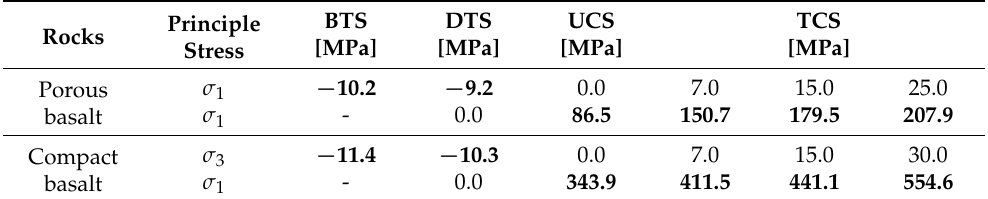
Table 4. Measured strengths for both the tested basalts (bold numbers) and corresponding princi- pal stresses at the failure for particular tests. BTS—Brazilian tension strength, DTS—estimation of direct tension strength ~0.9*BTS [75], UCS—uniaxial compressive strength, TCS—triaxial compressive strength.